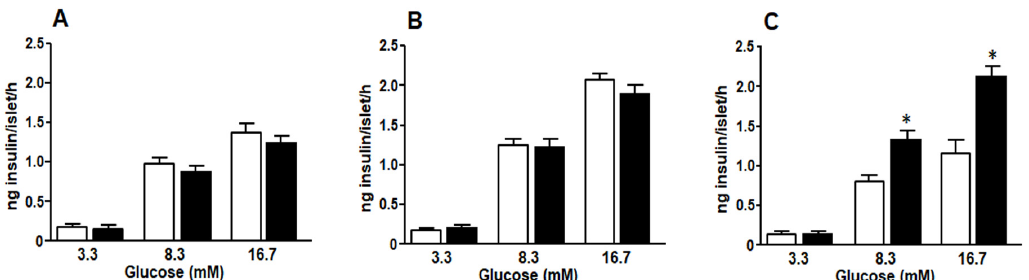
Figure 5. Glucose stimulated insulin secretion from pancreatic islets isolated from normal rats fed a standard control (white bars) or a fructose rich diet (black bars) for one ( A ) two ( B ) or three ( C ) weeks. Values are expressed as means ± SEM ( n = 12 rats per group) * p < 0.05 compared to each control at each time point.